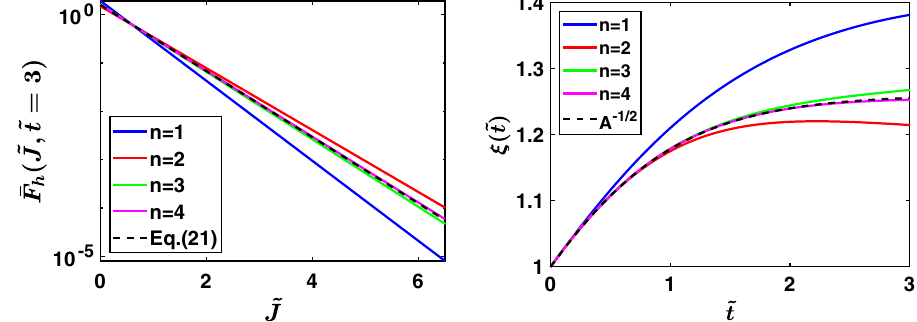
FIG. 2. Iterative numerical solution (colored plots) versus the analytical solution (dashed lines), for the distribution function (left) and the ξ -factor (right), assuming a test case with ν 0 ¼ 1 . 0 and D 0 ¼ 0 . 5 (the y-axis of the left plot is logarithmic). Here, n is the integer iteration index, and adequate convergence is achieved after four iterations.